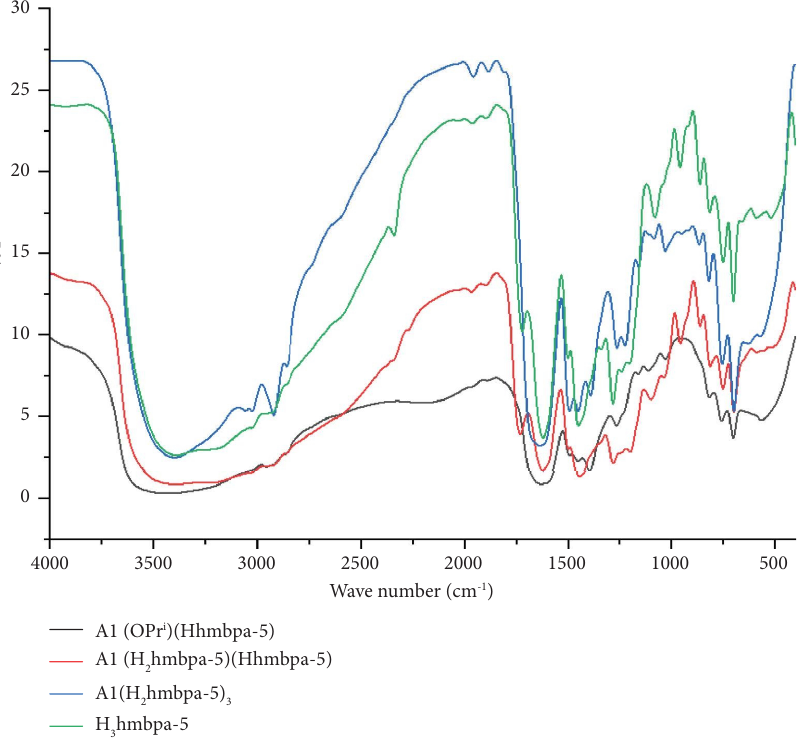
Figure 1: FT-IR spectrum of H 3 hmbpa-5 and the aluminium complexes ( 1a–1c ) (KBr